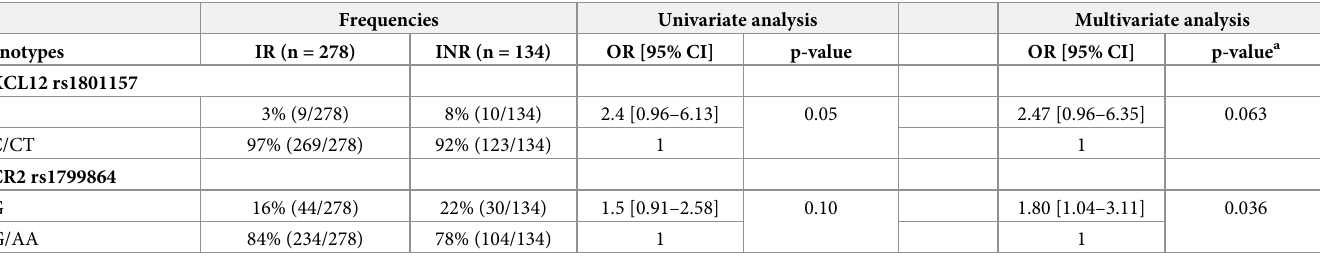
Table 3. Association of CXCL12 rs1801157 (recessive inheritance model) and CCR2 rs1799864 (over-dominant inheritance model) genotypes with INR status. Frequencies Univariate